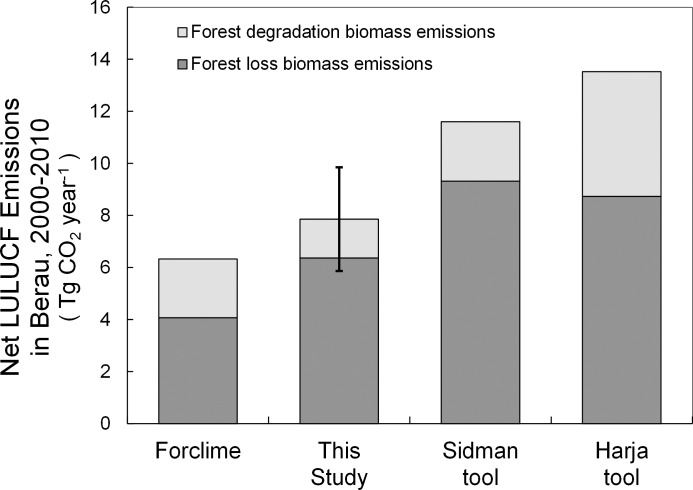
Comparison of alternative emissions estimates for Berau.Two alternative historic emissions estimates for Berau were higher than the upper end of our modeled uncertainty range (error bars are 95% confidence intervals). Those two estimates are from our use of emissions tools by Sidmanet al.[56] and Harjaet al.[57]. A fourth estimate by Forclime[22] fell below ours and within our uncertainty range.